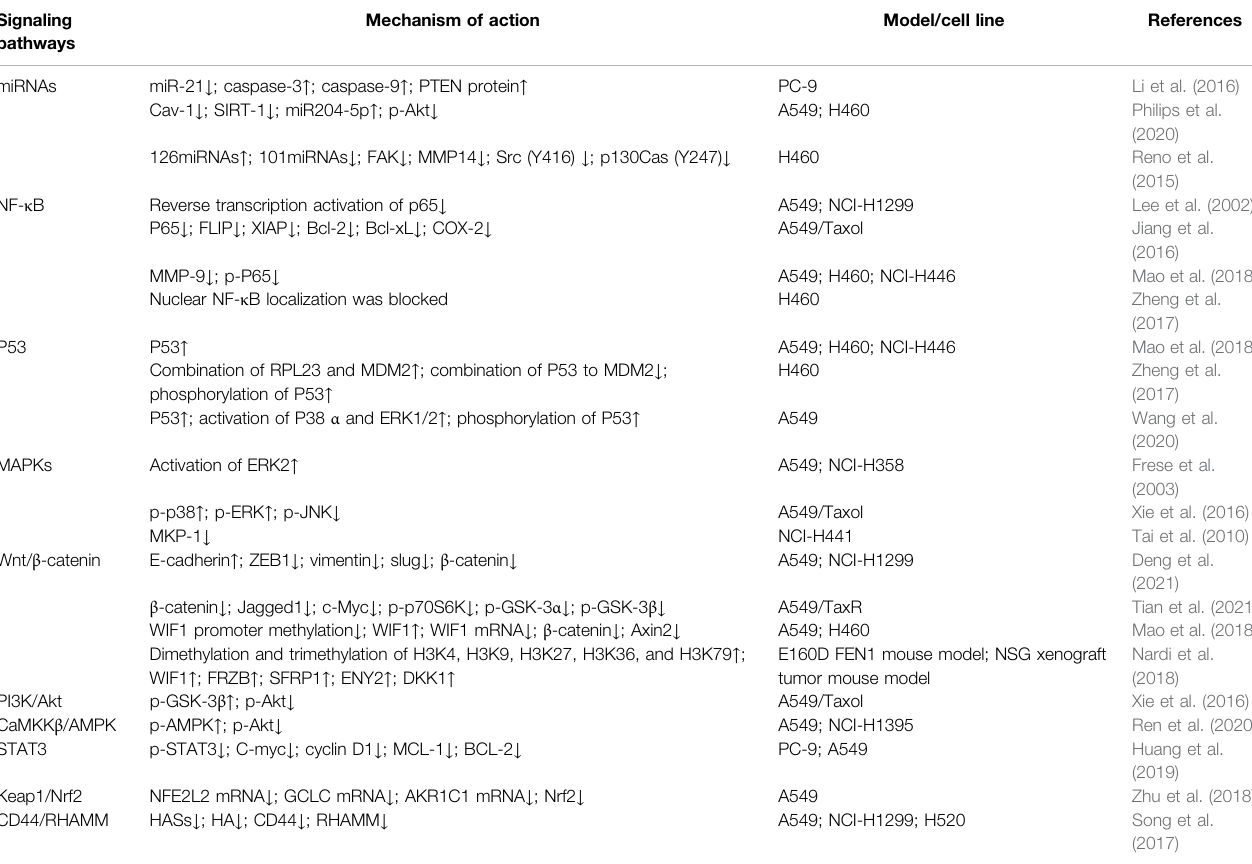
TABLE 1 | Mechanism of action of triptolide against non – small cell lung